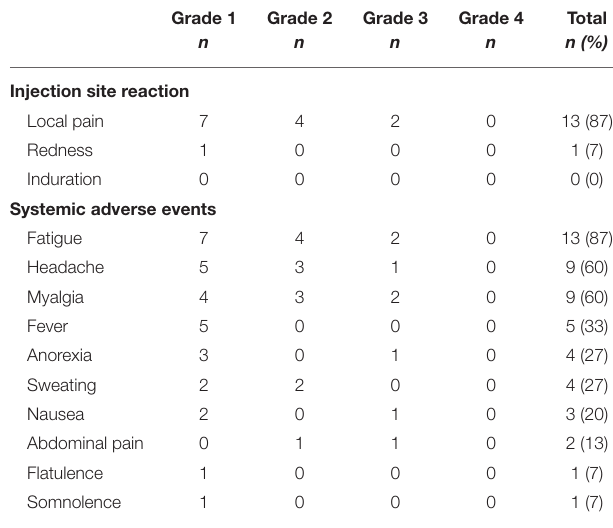
TABLE 2 | Summary of adverse events related to MVA.HIVconsv vaccinations ( n =